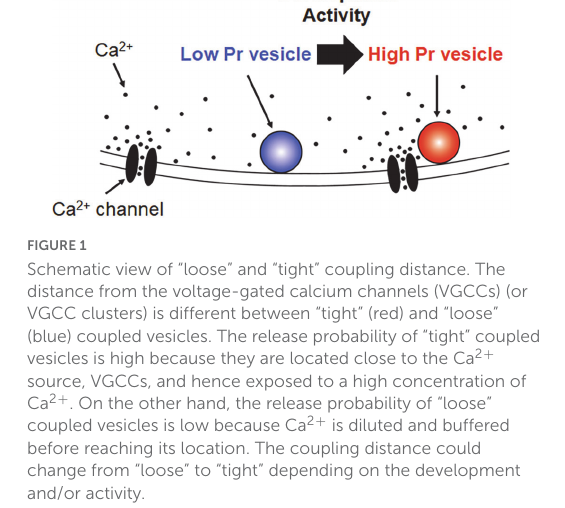
FIGURE2 Developmental and chronic/phasic activity-dependent tightening of the coupling distance. (A) The coupling distance was examined by ethylene glycol tetraacetic acid (EGTA) sensitivity. Different amount of EGTA was injected into the presynaptic terminals through the patch-pipette, and the amount of transmitter release was detected by the capacitance measurement technique. (B) At lemniscal fiber terminal (LFT), the coupling distance showed developmental tightening, which can be seen by reduced sensitivity of (cid:49) Cm after maturation (compare black and red traces). The developmental tightening was impaired when the animal was grown up in a sensory-deprived condition (green traces). (C) At hippocampal mossy fiber bouton (hMFB), chemical-induced LTP caused tightening of the coupling distance, which was indicated by the reduction of the EGTA sensitivity in an LTP condition. All traces are adapted from Midorikawa and Sakaba (2017) and Midorikawa and Miyata (2021).